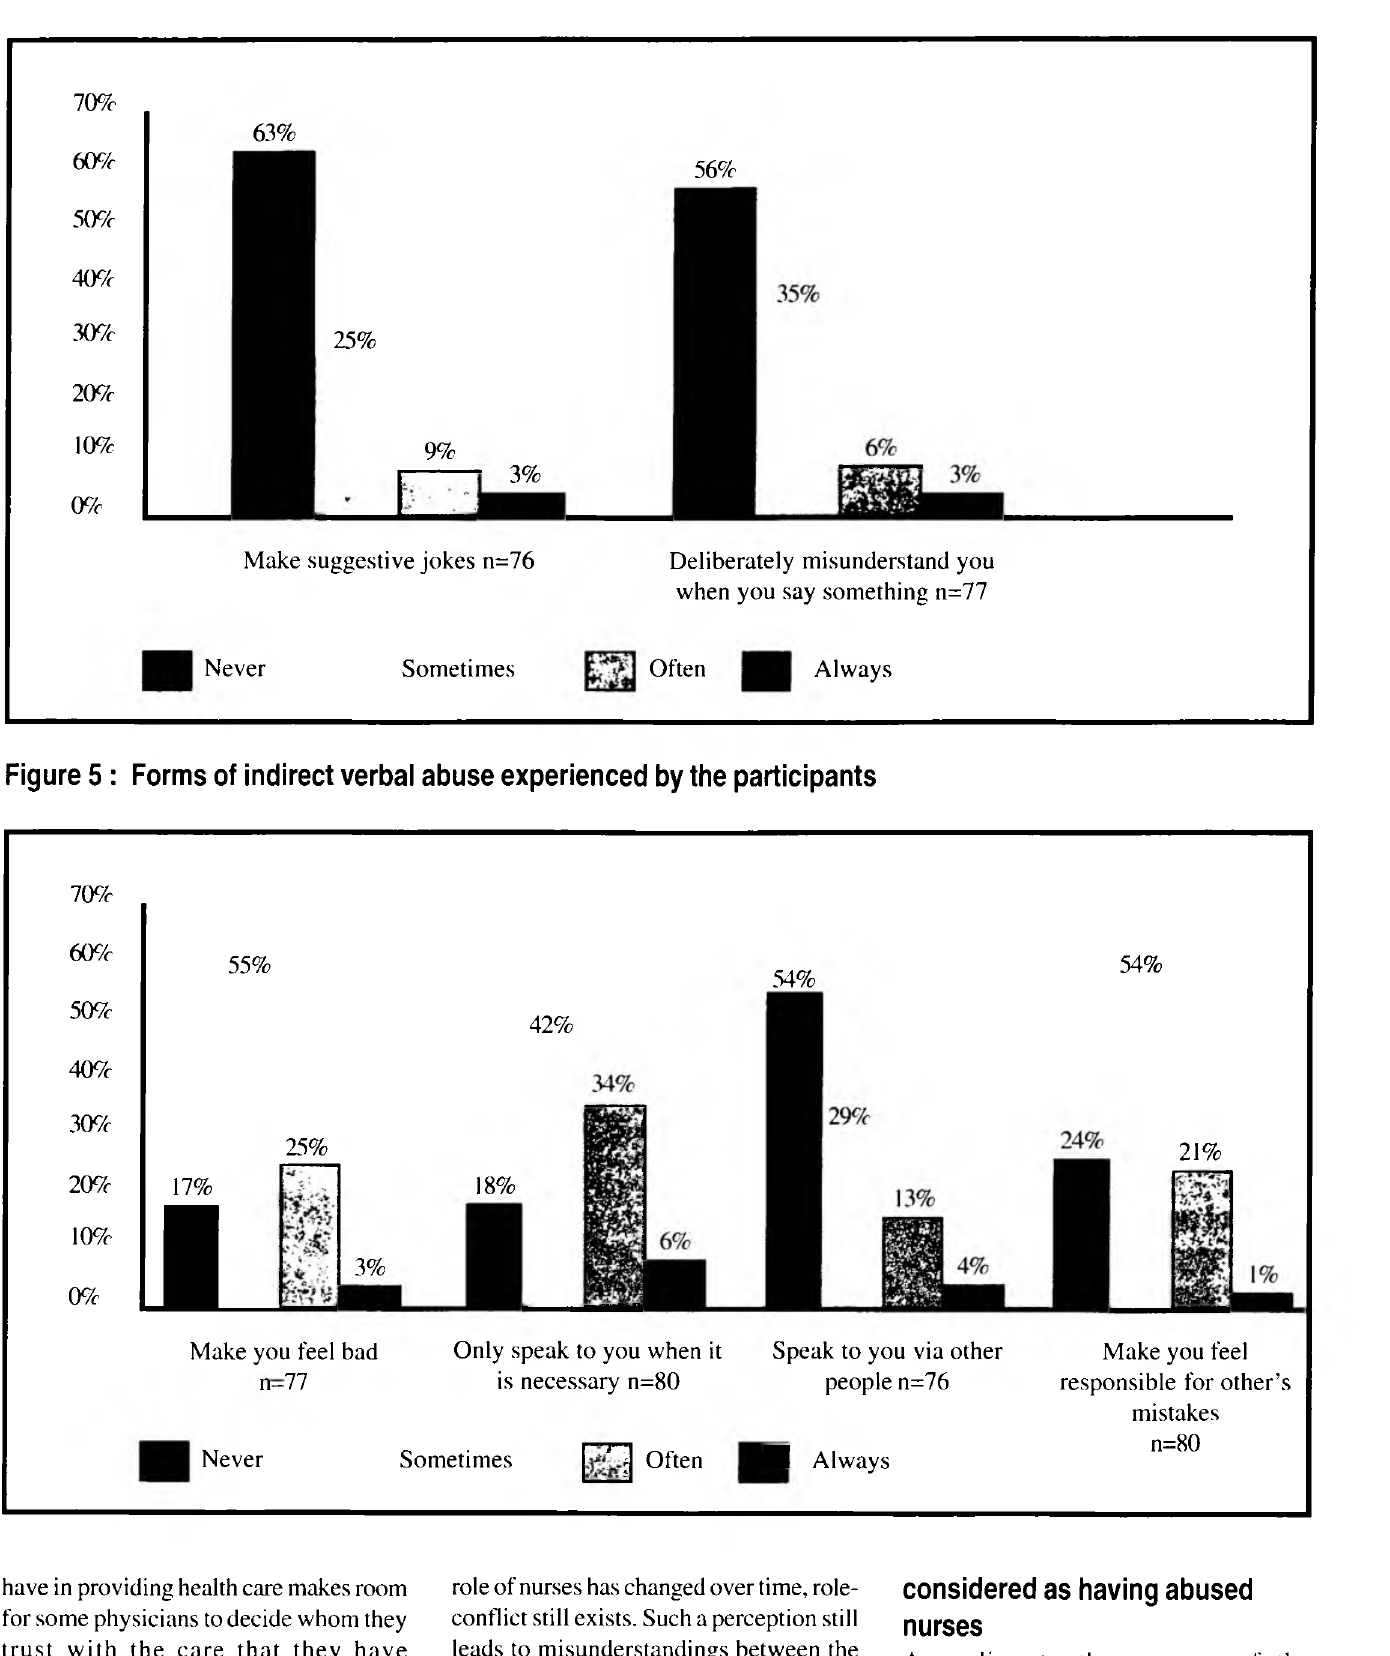
Figure 4: Forms of meanness experienced by the participants